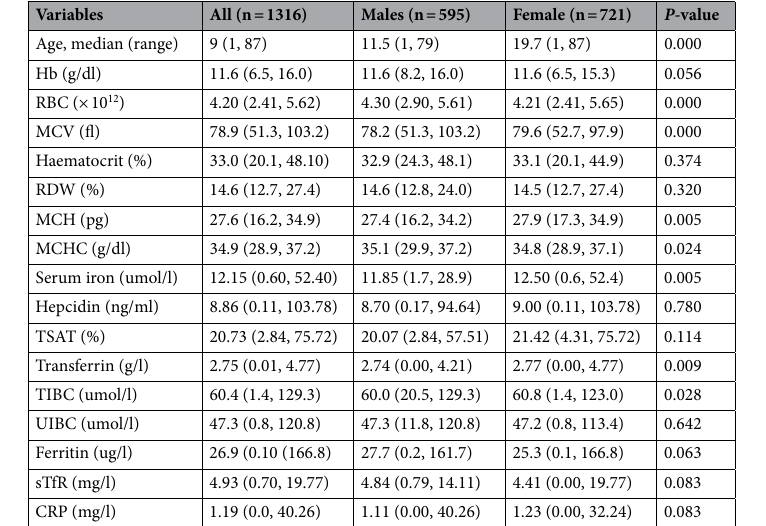
Table 1. Demographic characteristics of the study population. Data are presented in median (ranges), except gender. CRP C-reactive protein, Hb haemoglobin, MCV mean corpuscular volume, MCH mean corpuscular capacity, TSAT transferrin saturation.